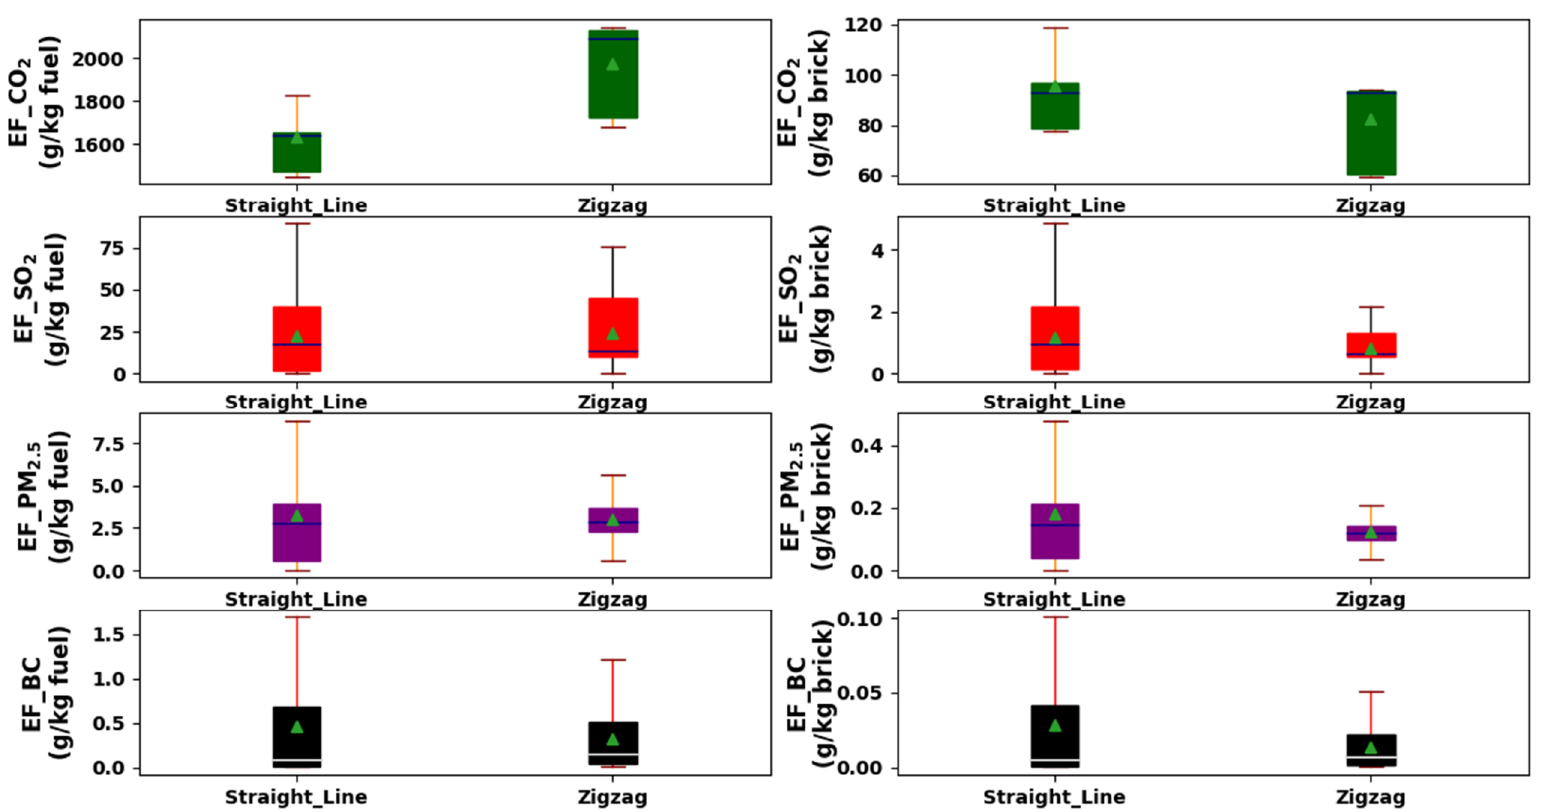
Figure 5. Box-and-whisker plots of the average of fuel-based (g/kg) and production-based (g/kg brick) emission factors of gaseous and particulate pollutants for straight-line and zigzag kilns. The boxes in the box-and-whisker plot extend from the Q1 to the Q3 quartile values of the data, having the difference between Q3 and Q1 as interquartile range (IQR), with a horizontal line at the median (Q2) and a triangle showing the mean value of the data. The position of the whiskers is set to 1.5 × IQR (IQR = Q3 – Q1) from the edges of the box where the green, orange, purple, and black box represent emission factors of CO 2 , SO 2 , PM 2.5 , and BC, respectively.